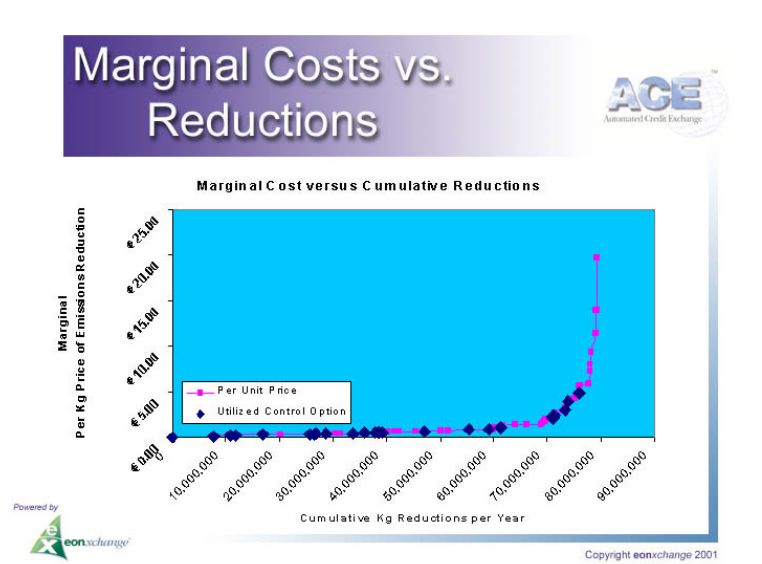
FIGURE 9. Marginal costs vs.